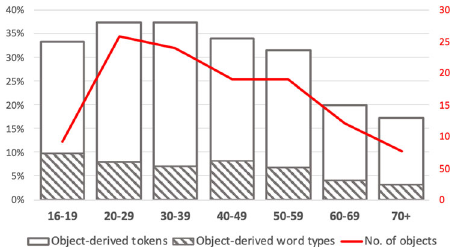
Fig. 11 Object-derived color terms. Percentage (left axis) of occurrences of object-derived color descriptors (tokens); percentage of occurrences of unique object-derived color words (word types) (superimposed, thatched), and absolute number of referent objects (right axis) in different age groups of Russian